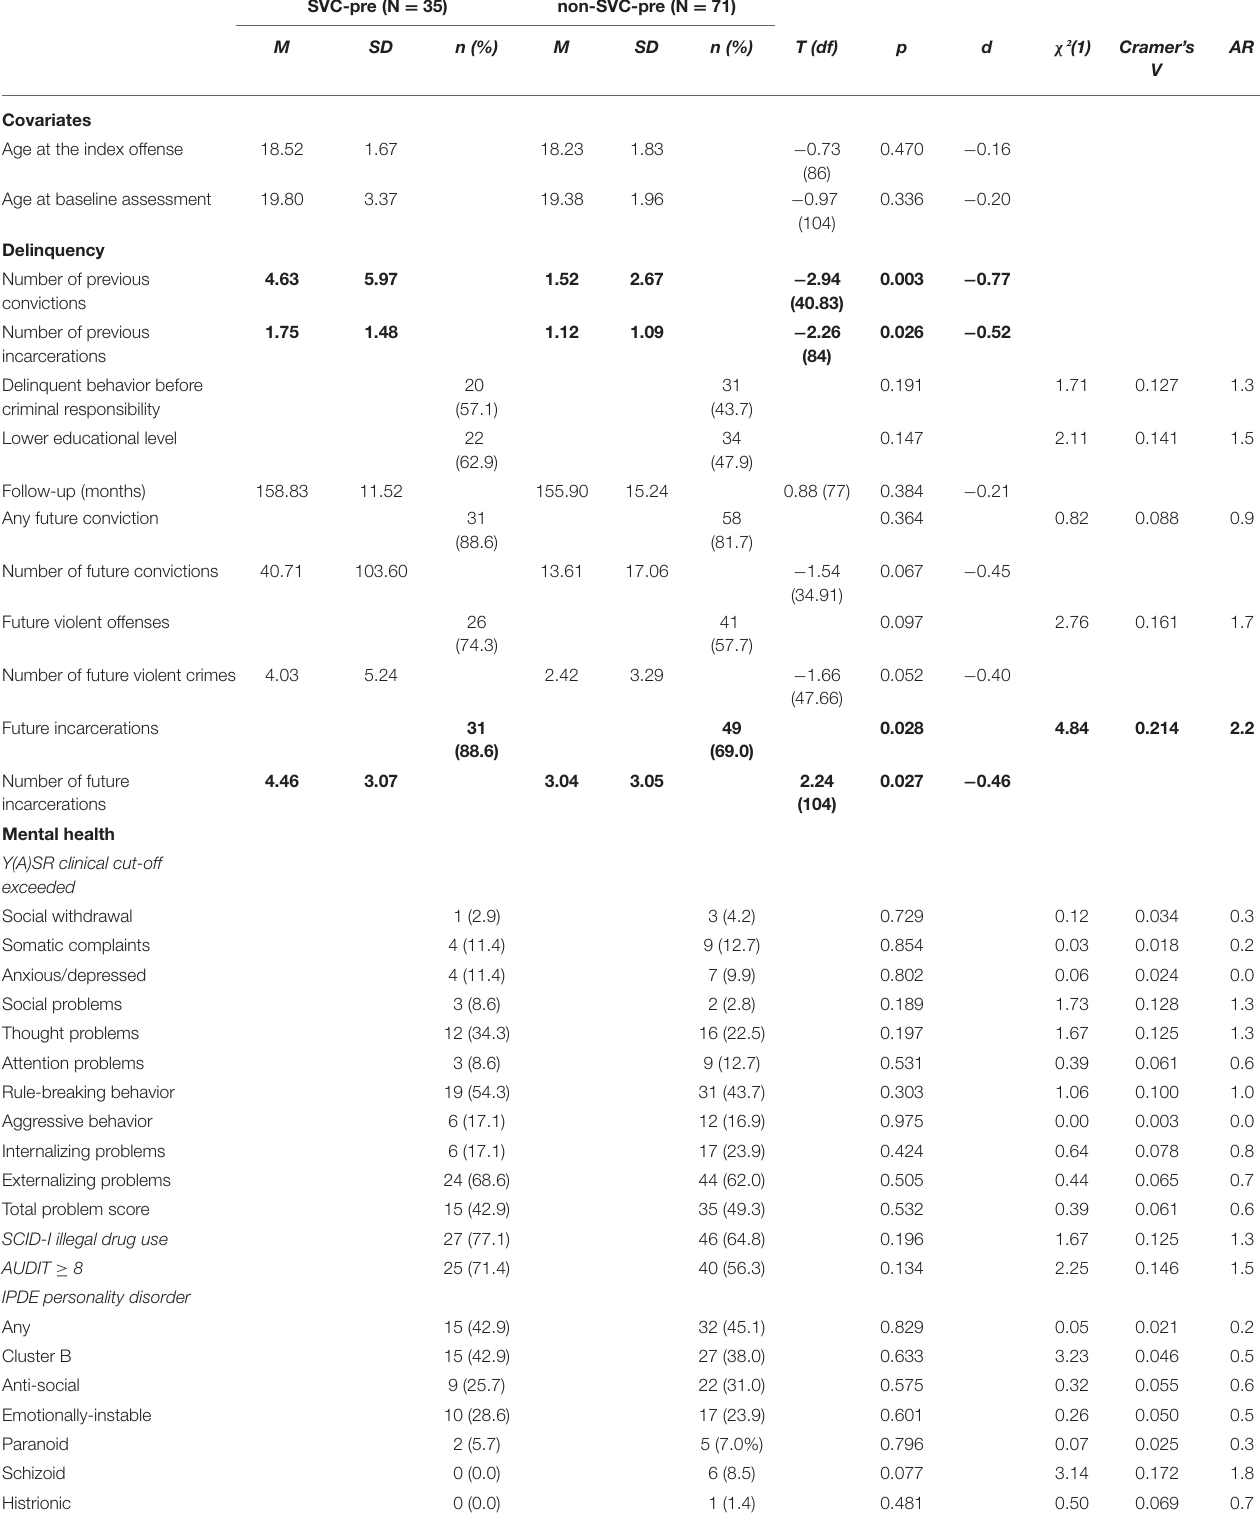
TABLE 1 | Differences between SVC-pre offenders and non-SVC-pre offenders. SVC-pre (N =